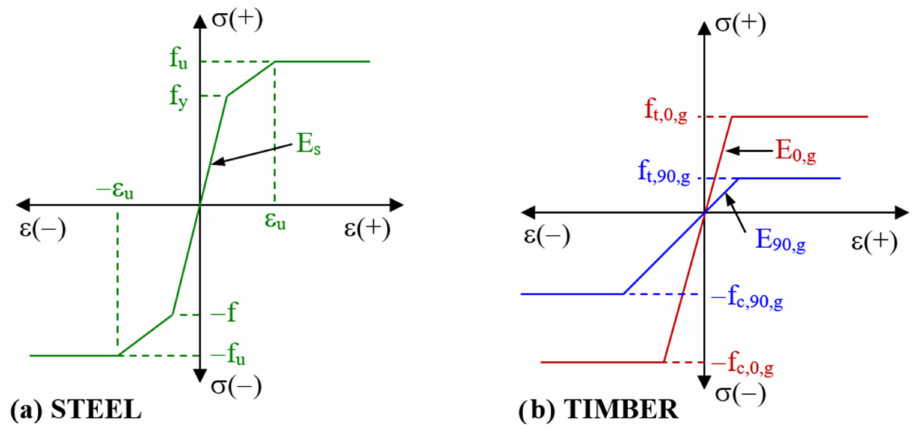
Figure 8. Uniaxial mechanical behavior models used for: ( a ) steel and ( b )